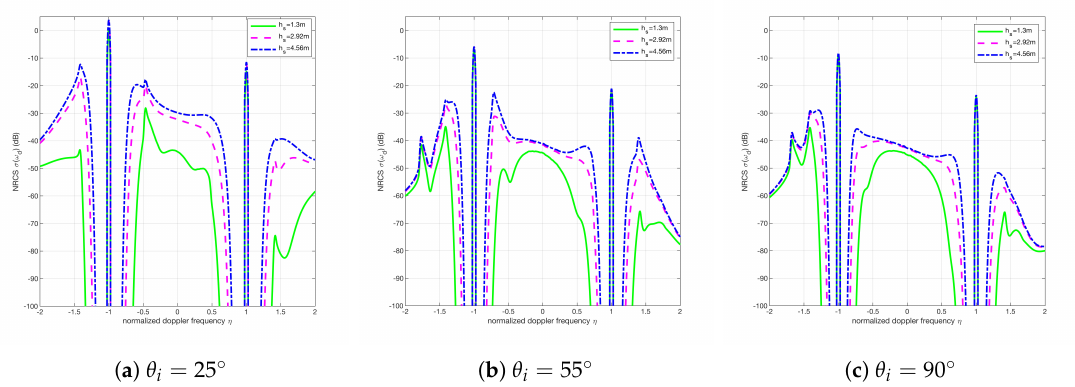
Figure 8. The Doppler spectra for different values of h s and θ i . ( a ) θ i = 25 ◦ . ( b ) θ i = 55 ◦ . ( c ) θ i = 90 ◦ . α (cid:48) = 45 ◦ and f c = 8 MHz. The Doppler spectra were simulated for three distinct values of h s , i.e., h s = 1.3 m,2.92 m and 4.56 m. These three values of h s correspond to U = 8 m/s, 12 m/s and 15 m/s, respectively.